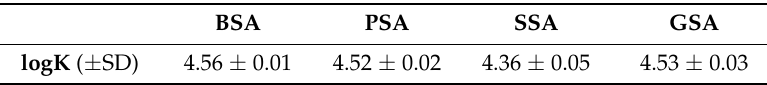
Table 2. Binding constants of TIL-serum albumin